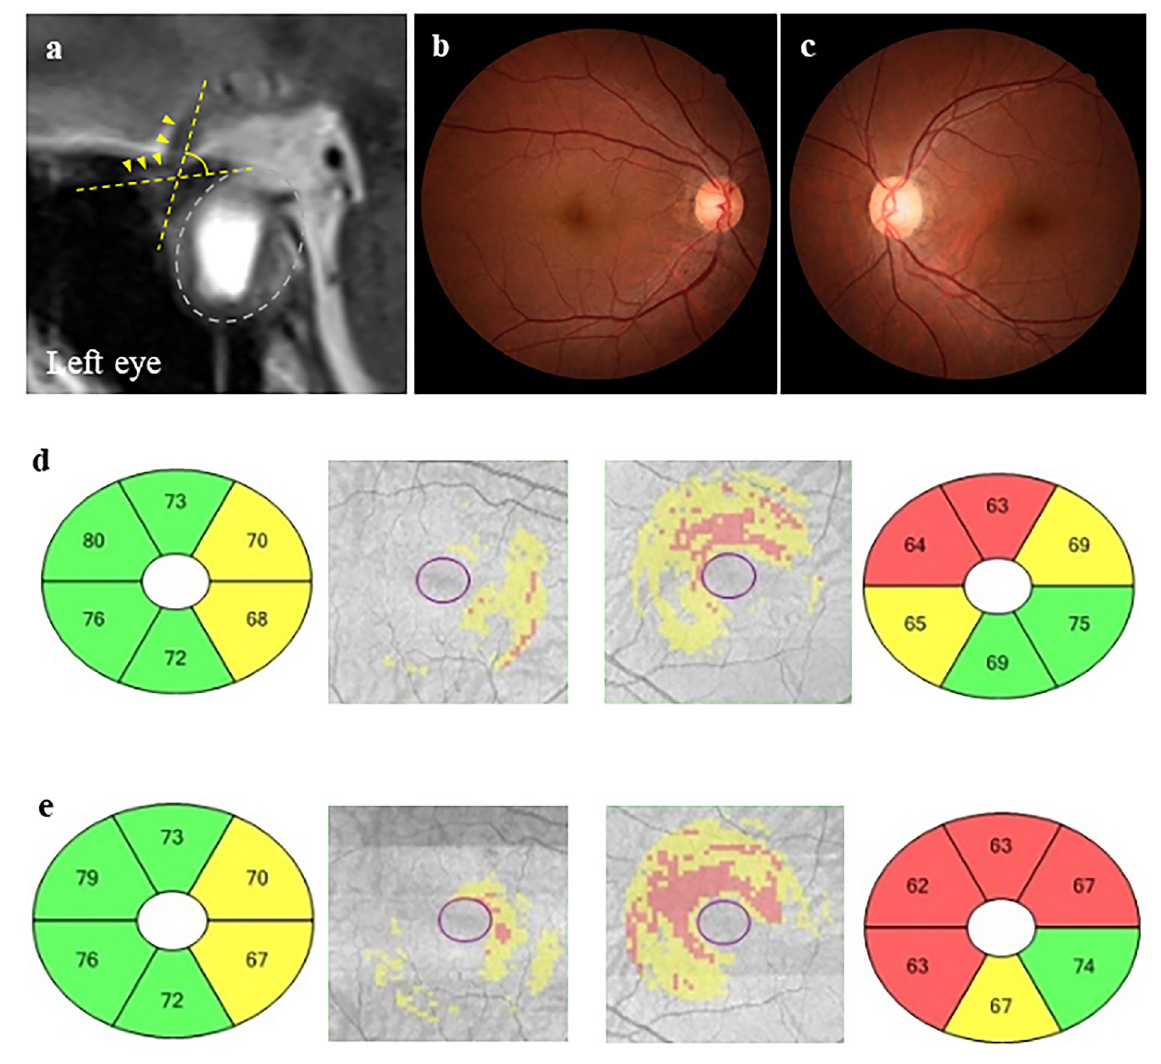
Figure 5. Representative clinical findings of a case with good visual outcome (case 1). A 63-year-old woman with pituitary adenoma with optic nerve bending in the left eye. Preoperative and postoperative best-corrected visual acuities (BCVAs) were − 0.08 and − 0.08 in the right eye and 0.82 and − 0.08 in the left eye logarithm of the minimum angle of resolution units, respectively. ( a ) Preoperative sagittal T2-weighted magnetic resonance images. The optic nerve–canal bending angle (ONCBA) was formed by the optic nerve (nerve indicated by yellow arrowheads) in the optic canal and the optic nerve in the intracranial subarachnoid space at the optic canal’s exit (angle indicated by yellow dotted lines). White dotted lines indicate a tumor. The ONCBAs of this case were 31° in the right eye and 76° in the left eye. Therefore, the left eye is the one with optic nerve bending. ( b , c ) Color fundus photograph showing the normal appearance at preoperative visit (B, right eye; C, left eye). ( d , e ) Ganglion cell layer (GCL) + inner plexiform layer (IPL) deviation map showing the expansion from the parafovea to the periphery of the red area indicates the decrease of GCL + IPL thickness and outside normal limits. GCL + IPL deviation map and sector graph of the right eye (left 2 panels) and left eye (right 2 panels) show a decrease in the macular GCL + IPL thickness, especially from nasal to superior sectors in the left eye. A slight decrease in postoperative GCL + IPL thickness is observed in the left eye ( d , preoperative; e , postoperative